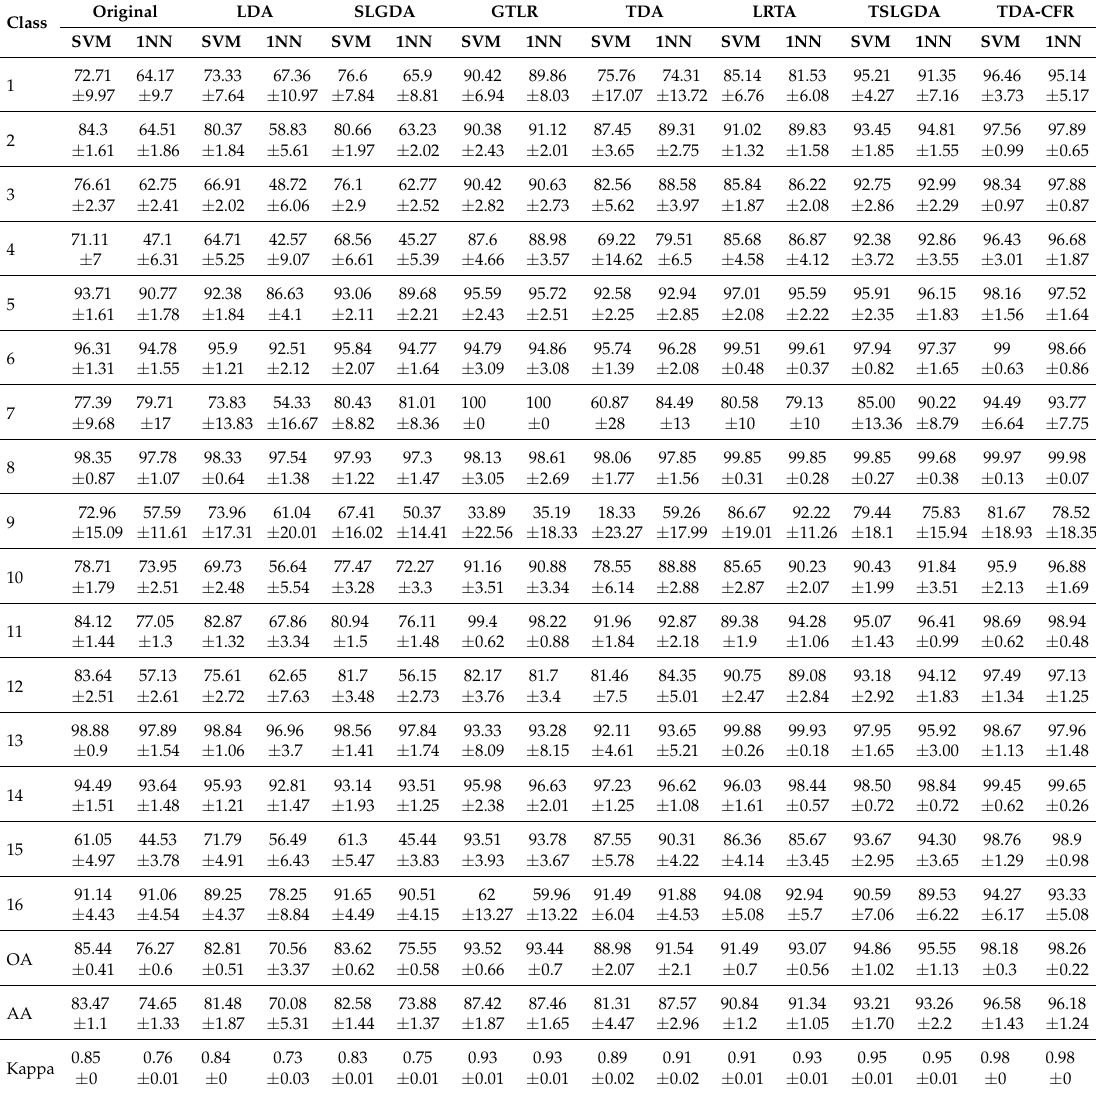
Table 1. Classification results on Indian